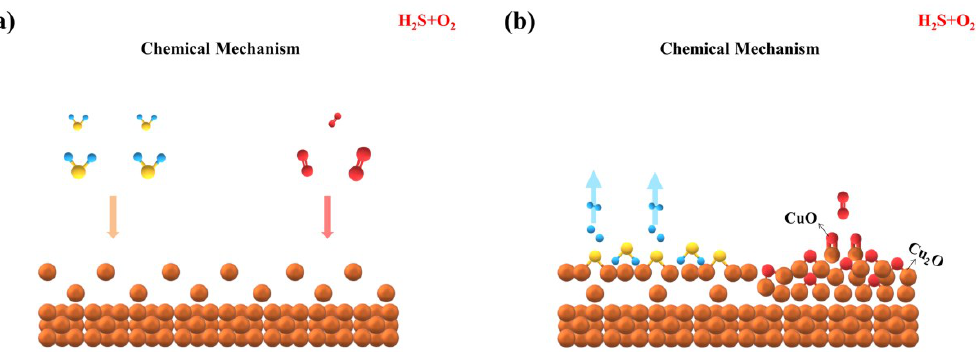
Figure 13. Schematic diagram of corrosion steps of copper sheet in LPG with H 2 S + O 2 . ( a ) step1. ( b ) step2.